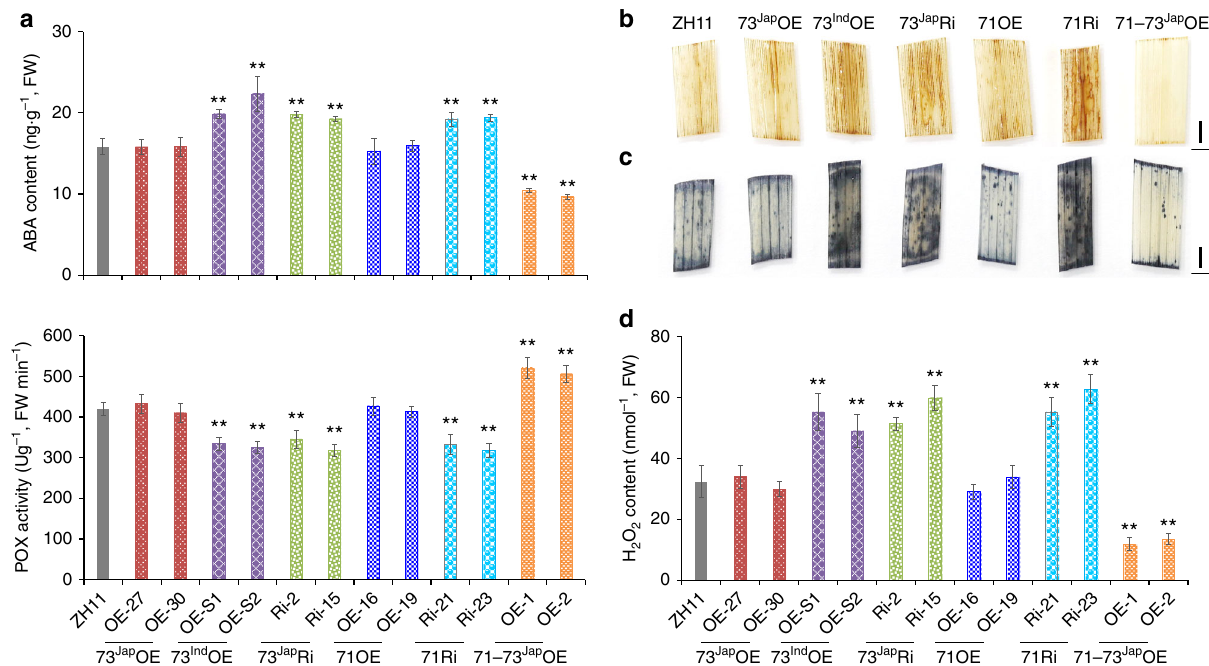
Fig. 3 Metabolic responses of wild-type and transgenic rice lines under cold stress. a ABA content ( n = 3, 32 plants/replication) and peroxidase (POX) enzyme activity ( n = 8, 10 plants/replication) of transgenic lines under cold stress. b The 3,3 ’ -diaminobenzidine (DAB) and c nitroblue tetrazolium (NBT) staining for the visualization of H 2 O 2 and O 2 − , respectively, in cold-treated rice leaves. Scale bars, 2 mm. d H 2 O 2 content ( n = 8, 10 plants/replication) of transgenic lines under cold stress. OE, overexpression; Ri, RNA interference; 73 Jap , bZIP73 Jap ; 73 Ind , bZIP73 Ind ; 71, bZIP71 ; 71 – 73 Jap OE, overexpression of both bZIP71 and bZIP73 Jap ; FW, fresh weight. All experiments were conducted using two-week-old seedlings. Error bar, standard deviation; ** p < 0.01, two- tailed t